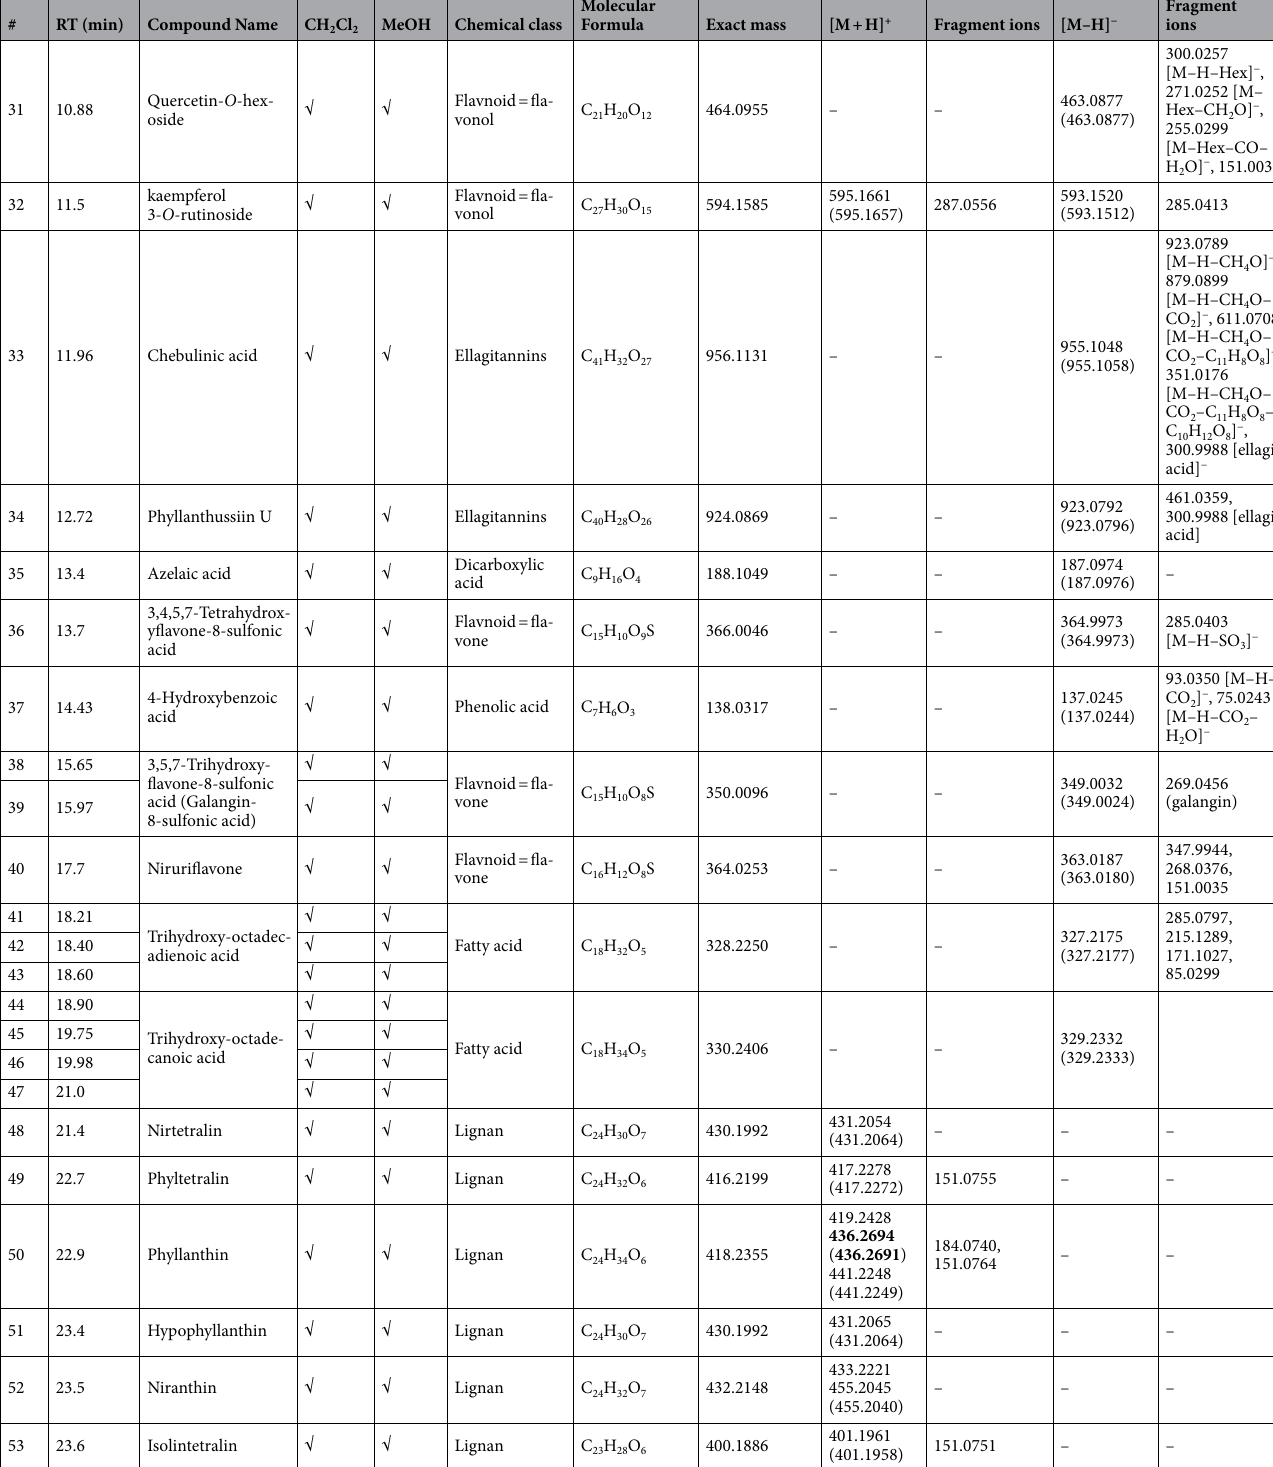
Table 1. Tentative identification and characterization of phytochemical compounds in Phyllanthus niruri leaf and stem using LC-QToF in positive and negative ionization modes. Significant values are in bold. *Theoretical accurate mass; Compound # 5, 9–14 are present in low abundances in methylene chloride